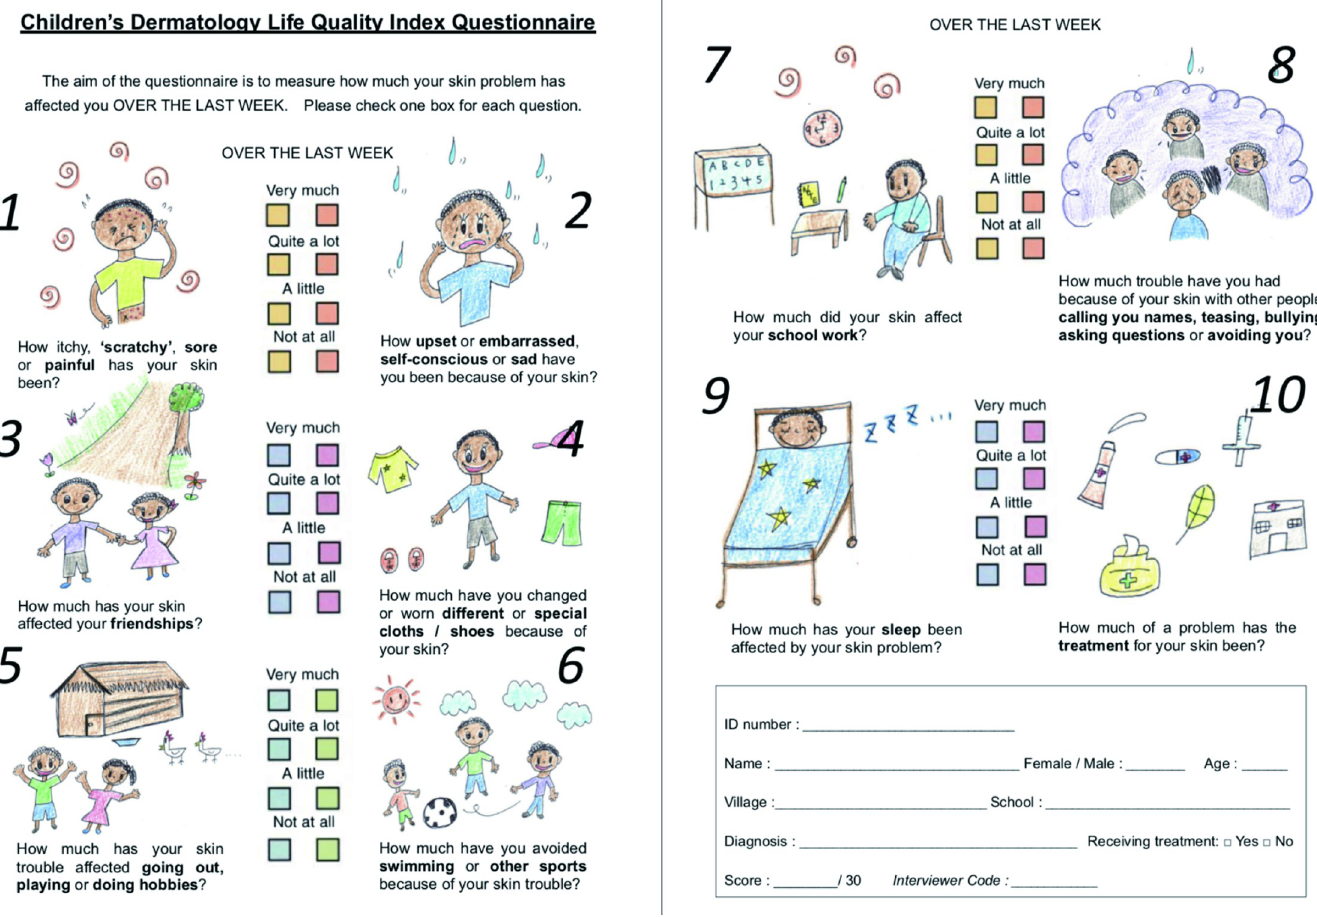
Fig 2. Modified Children’s Dermatology Life Quality Index (CDLQI) questionnaire [English version].